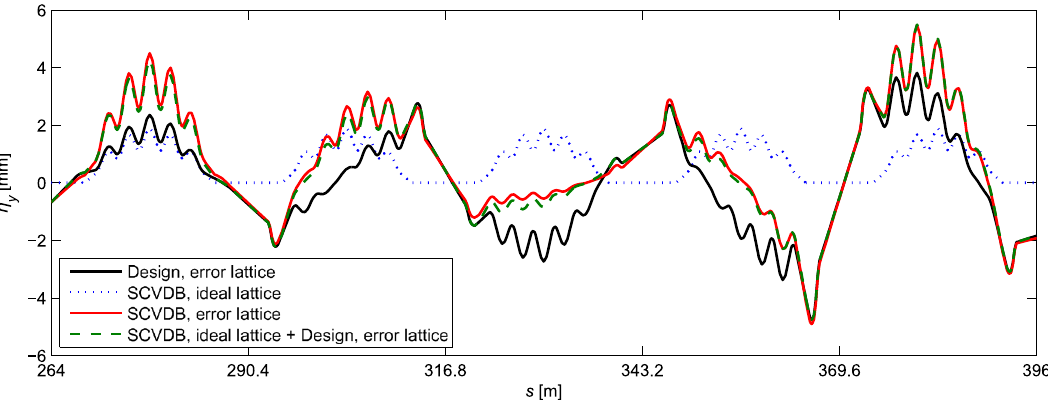
FIG. 7. Detail of vertical dispersion Case 3 in five achromats. Adding the vertical dispersion from the two independent sources, lattice imperfections and SCVDBs, linearly leads to a good estimate of the vertical dispersion under the influence of lattice